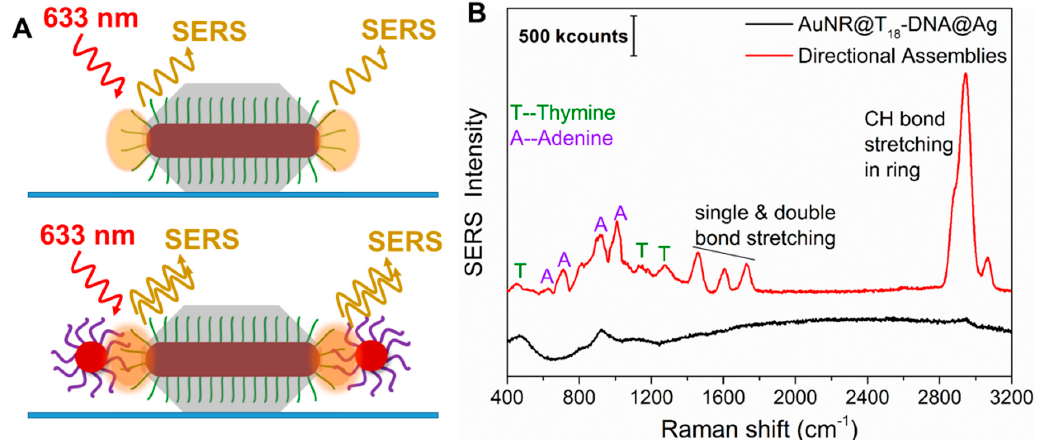
Figure 5. ( A ) Sketch of the anisotropic directional building blocks (AuNRs@T 18 -DNA@Ag 50min , top) and their anisotropic directional nanoassemblies (bottom). The orange shading highlights the spots of highest electric-field enhancement, i.e., the strategically positioned hot-spots that can lead to SERS of the ssDNA (top panel) or of the dsDNA (bottom panel). ( B ) Representative SERS spectra of a single AuNRs@T 18 -DNA@Ag (directional building block, black curve) and of a single anisotropic directional nanoassembly (red curve), as investigated by dark-field microscope (DFM)-SERS ( λ laser = 633 nm). The characteristic SERS peaks from A and T are indicated.